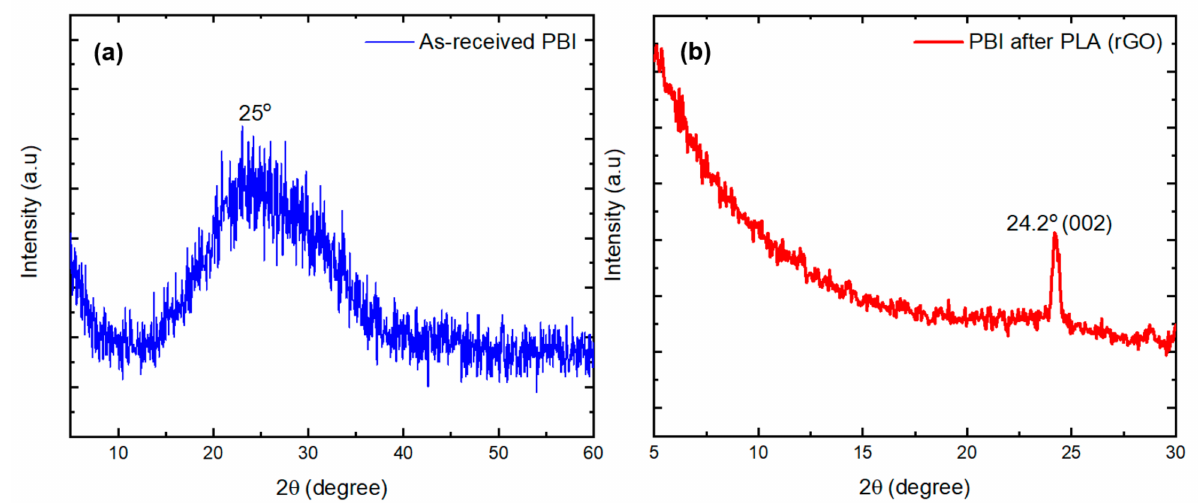
Figure 7. XRD pattern of ( a ) as-received PBI and ( b ) after laser annealing of PBI.